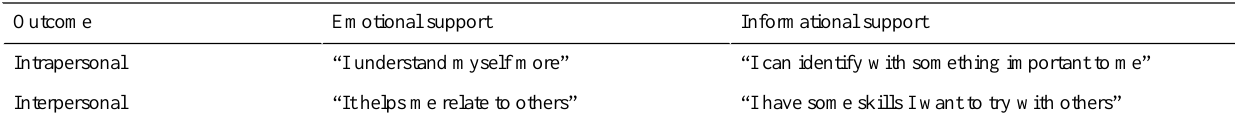
Table 1. High-level outcome matrix for Kooth